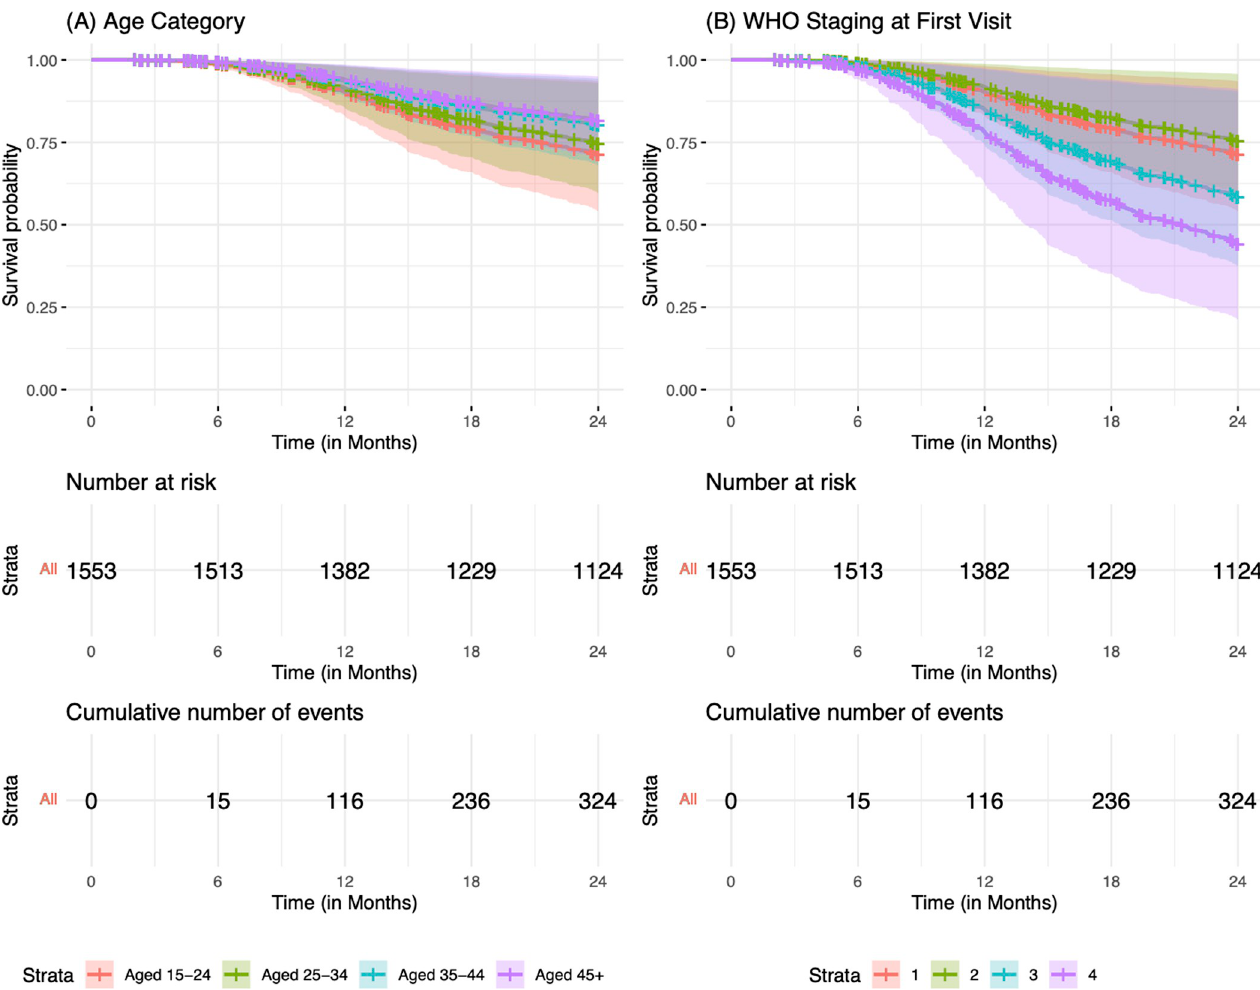
Fig 4. Kaplan-Meier estimate of loss-to-follow-up per age category and WHO clinical stage classification at registration in care and treatment among patients followed for 24